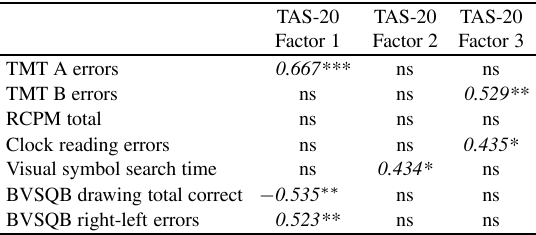
Table 3 Correlations between alexithymia factor scores and performance